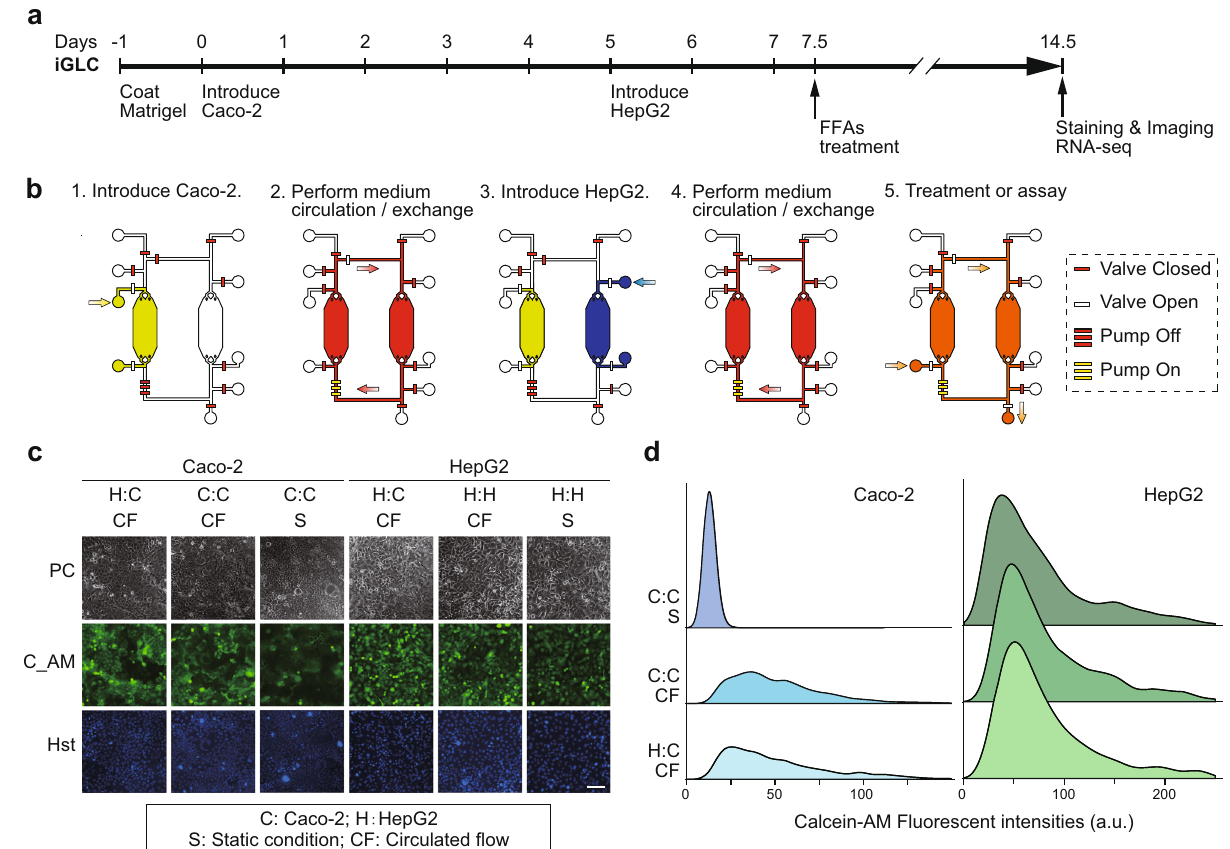
Fig. 2 Establishment of the GLA in the iGLC platform. a , b Experimental procedure to culture Caco-2 and HepG2 cells in an iGLC platform (see also Supplementary Methods). Brie fl y, after a micro fl uidic channel was washed with a fresh cell culture medium, all valves were closed to prevent air contamination into the chip. Two valves next to the cell culture chamber were opened, and cell suspensions of Caco-2 and HepG2 cells were separately introduced into the corresponding chambers. After 1 day of incubation at 37 °C to settle down the cells, the pump was actuated to circulate the medium. The cell culture medium was changed every 6 h. c Phase-contrast (PC) and fl uorescent micrographs of Caco-2 and HepG2 cells with closed medium circulation in the iGLC platform and stained with Calcein AM (C_AM) and Hoechst 33258 (Hst). For comparison, we also assessed individually cultured Caco-2 (C:C) and HepG2 (H:H) cells under circulation fl ow (CF) and static conditions (S). H:C represents co-cultured Caco-2 and HepG2 cells. The scale bar represents 100 µ m. d Ridgeline plots showing single-cell pro fi ling of Caco-2 and HepG2 cells stained with Calcein AM. For comparison, we also assessed individually cultured Caco-2 (C:C) and HepG2 (H:H) cells under circulation fl ow (CF) and static conditions (S). H:C represents co-cultured Caco- 2 and HepG2 cells. The p -values were estimated with the Tukey – Kramer test and are presented in Supplementary Table S1 for the Caco-2 and Supplementary Table S2 for HepG2